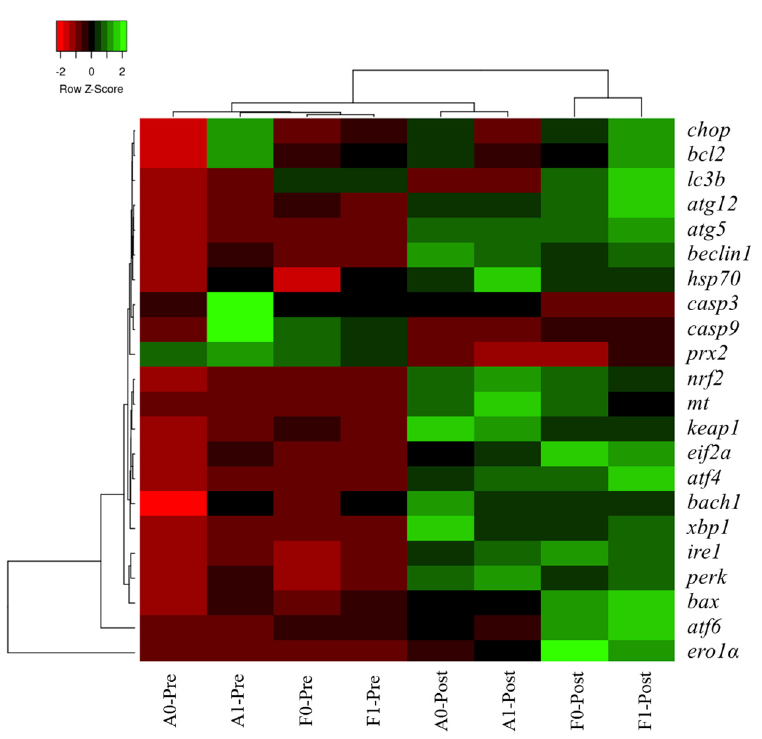
Figure 9. Gene expression heatmap of genes related to antioxidation, ER stress, autophagy, and apoptosis in the livers of gibel carp.